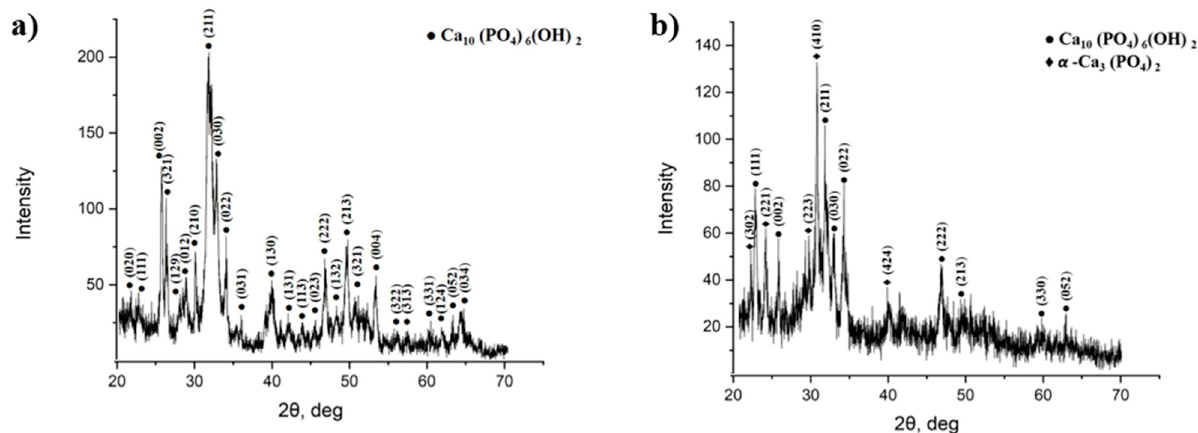
Figure 8. Diffraction patterns of HA powder ( a ) and HA coating obtained by PEO/GDS methods ( b ).